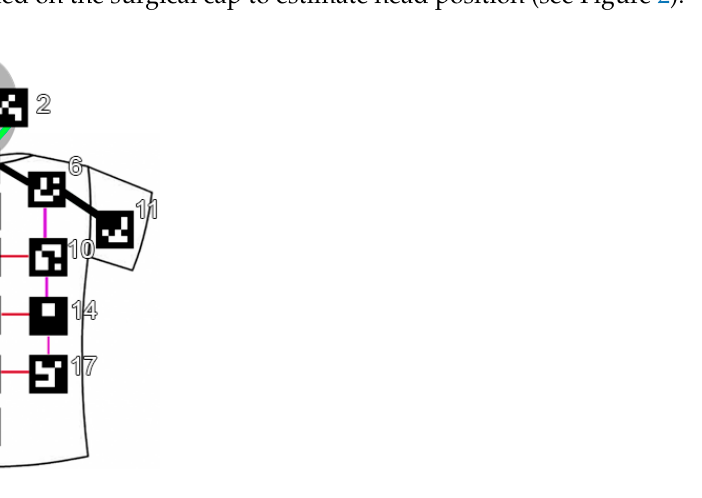
Figure 2. A schematic representation of the position of the 18 ArUco planar markers sewn on the T-shirt worn by the operator. The identification number is used in the following.